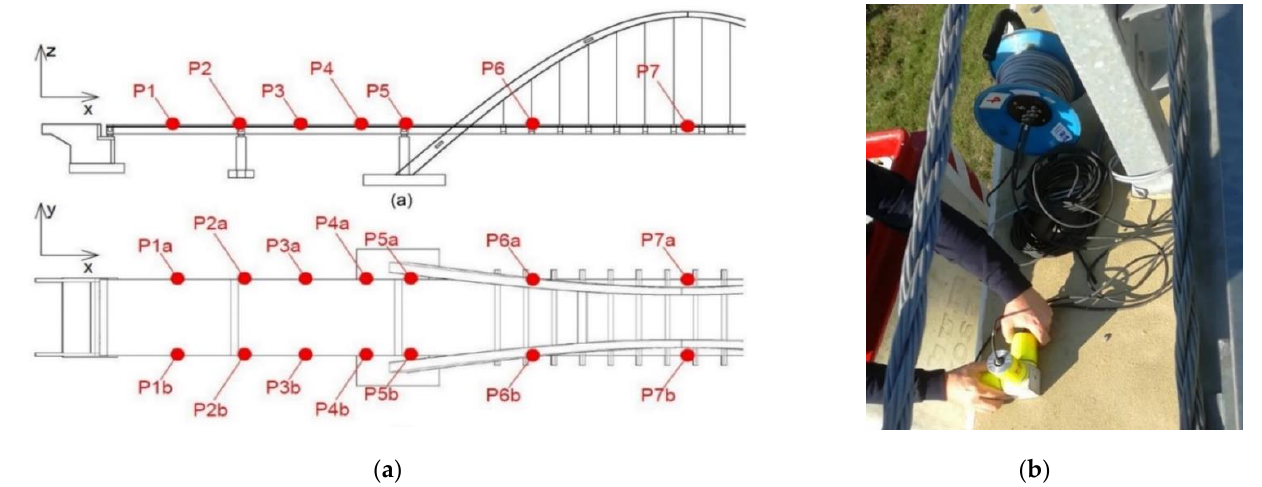
Figure 8. ( a ) Layout of measurement points for evaluation of modal properties of the bridge, ( b ) sensor assembly.